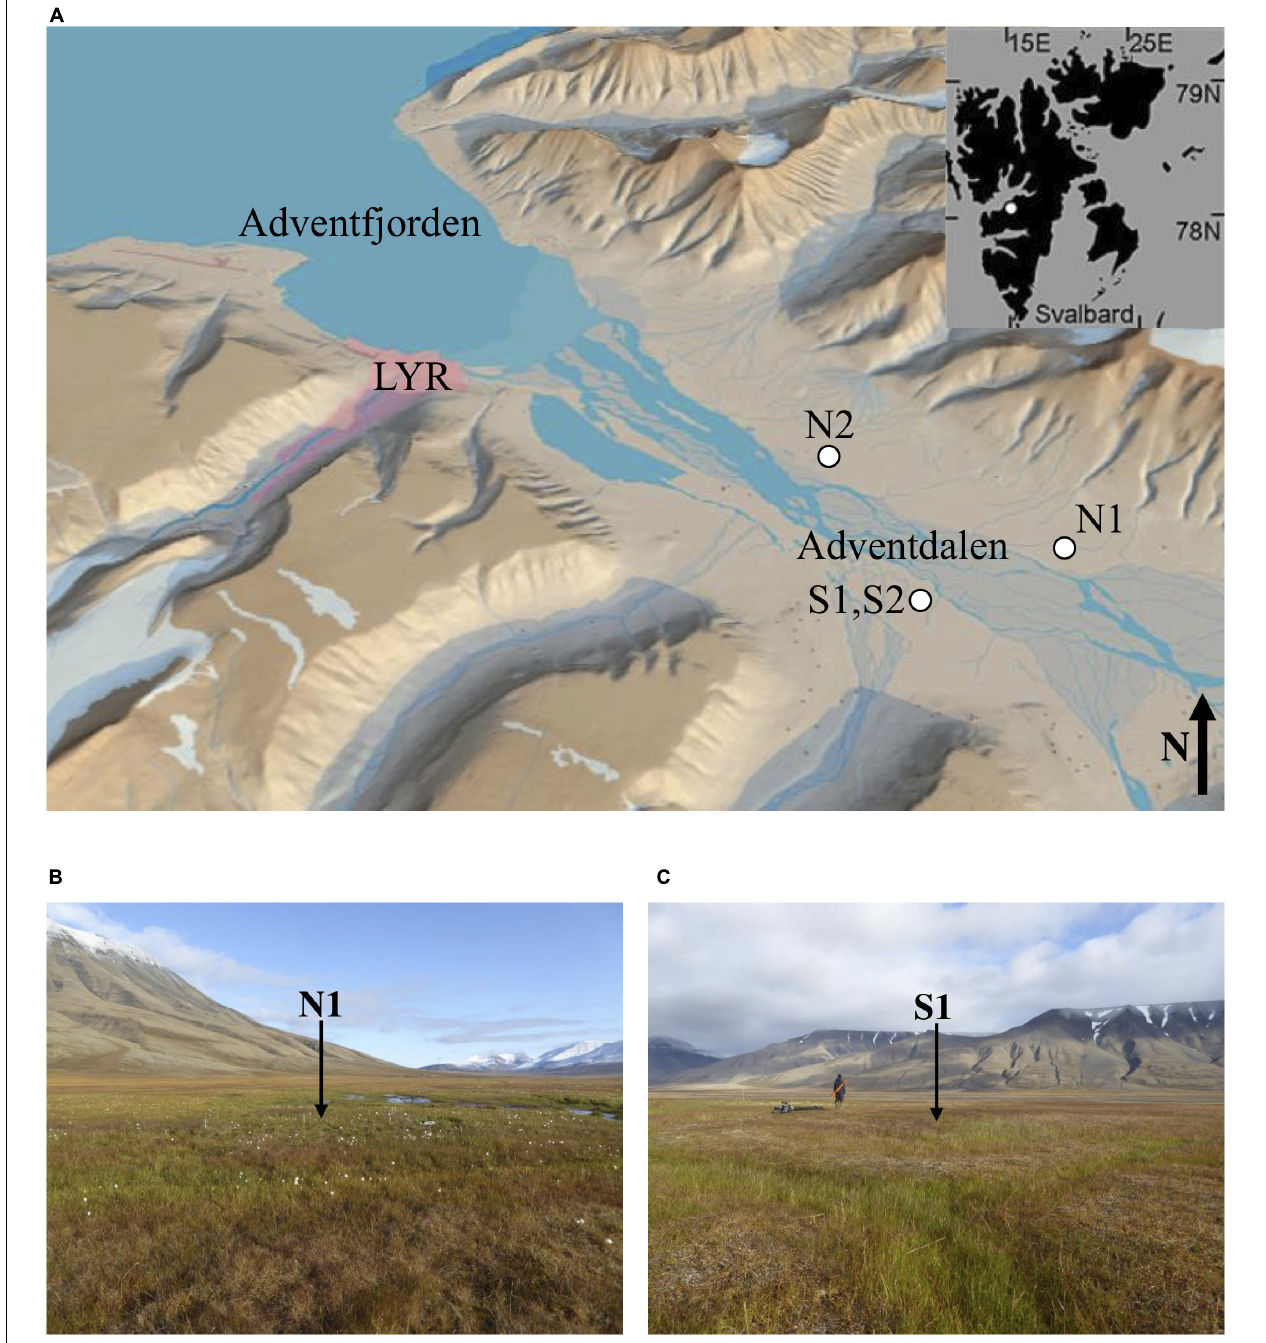
FIGURE 1 | (A) The Svalbard archipelago (inset) and Adventdalen, with a white circle indicating each site where ice-wedge polygons were sampled (courtesey of the Norwegian Polar Institute), (B) overlooking polygon N1, facing east, and (C) overlooking polygon S1, facing north. Photo credit: E. L. Jones.